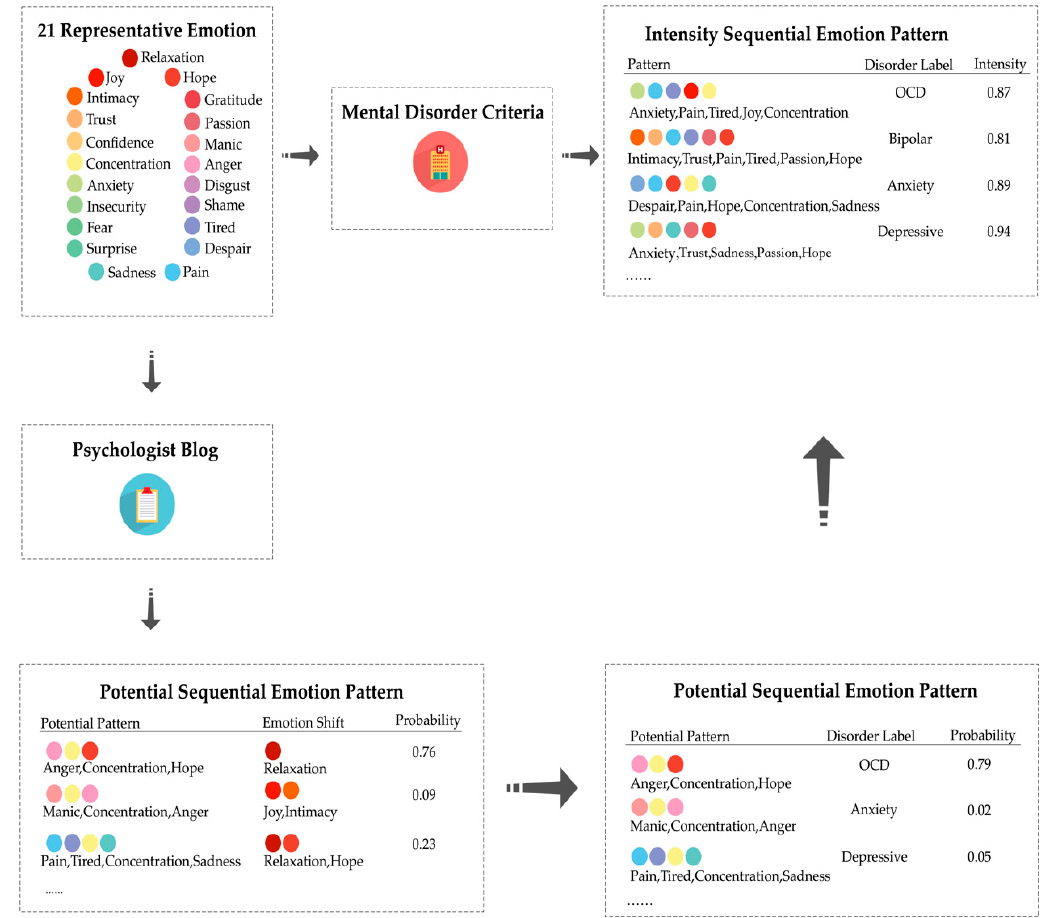
Figure 4. The process of using 21 representative emotions to generate an intensity sequential emotion pattern.